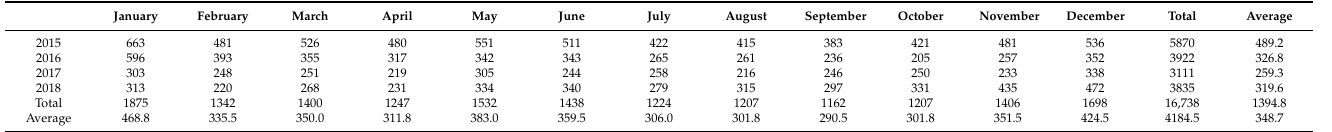
Table 3. Monthly numbers of newly diagnosed pediatric Kawasaki disease patients in